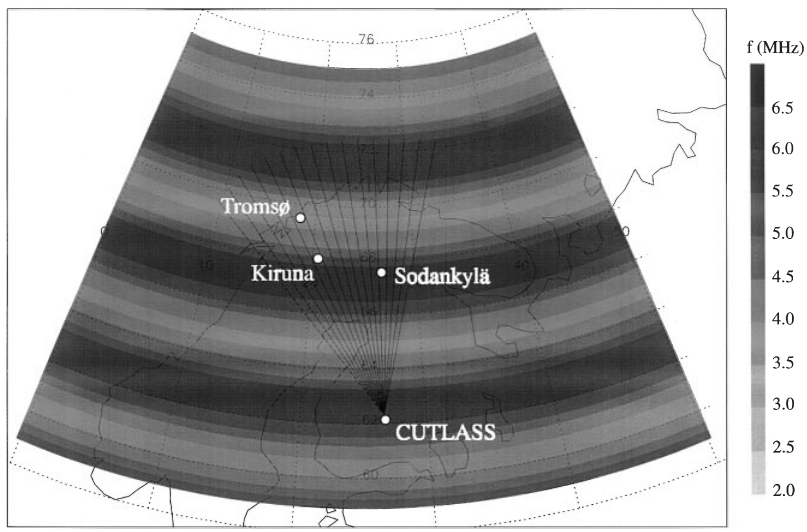
Fig. 1. A map showing the location of the Kiruna, Sodankyla¨ , and Tromsø ionosondes and the CUTLASS (Finland) station. Also shown are the 16 radar beams (at an elevation of 16 (cid:176) and a frequency of 9.97 MHz) and the variation in the plasma frequency at a height of 208 km caused by the